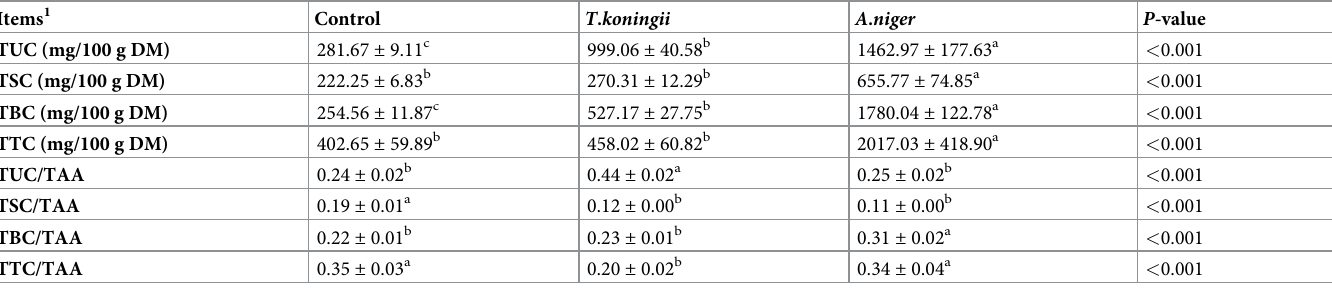
Table 4. Flavored components in the fermented tea dregs. Items